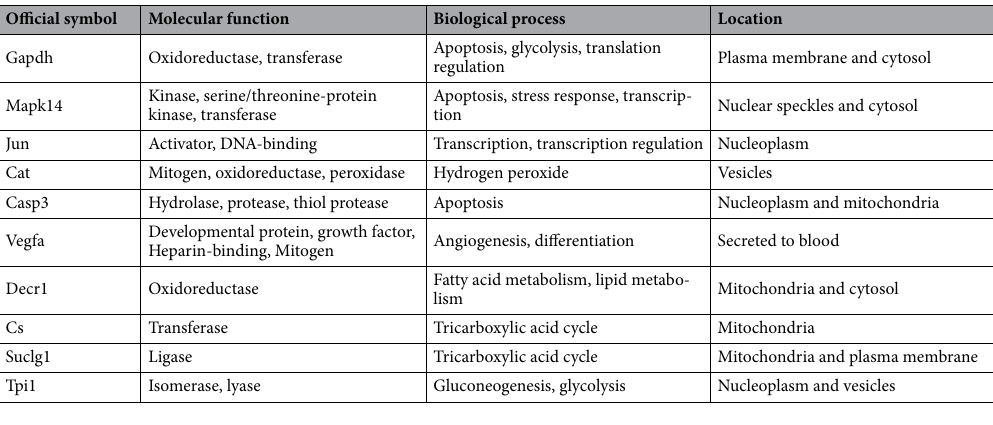
Table 3. Description of top10 proteins in